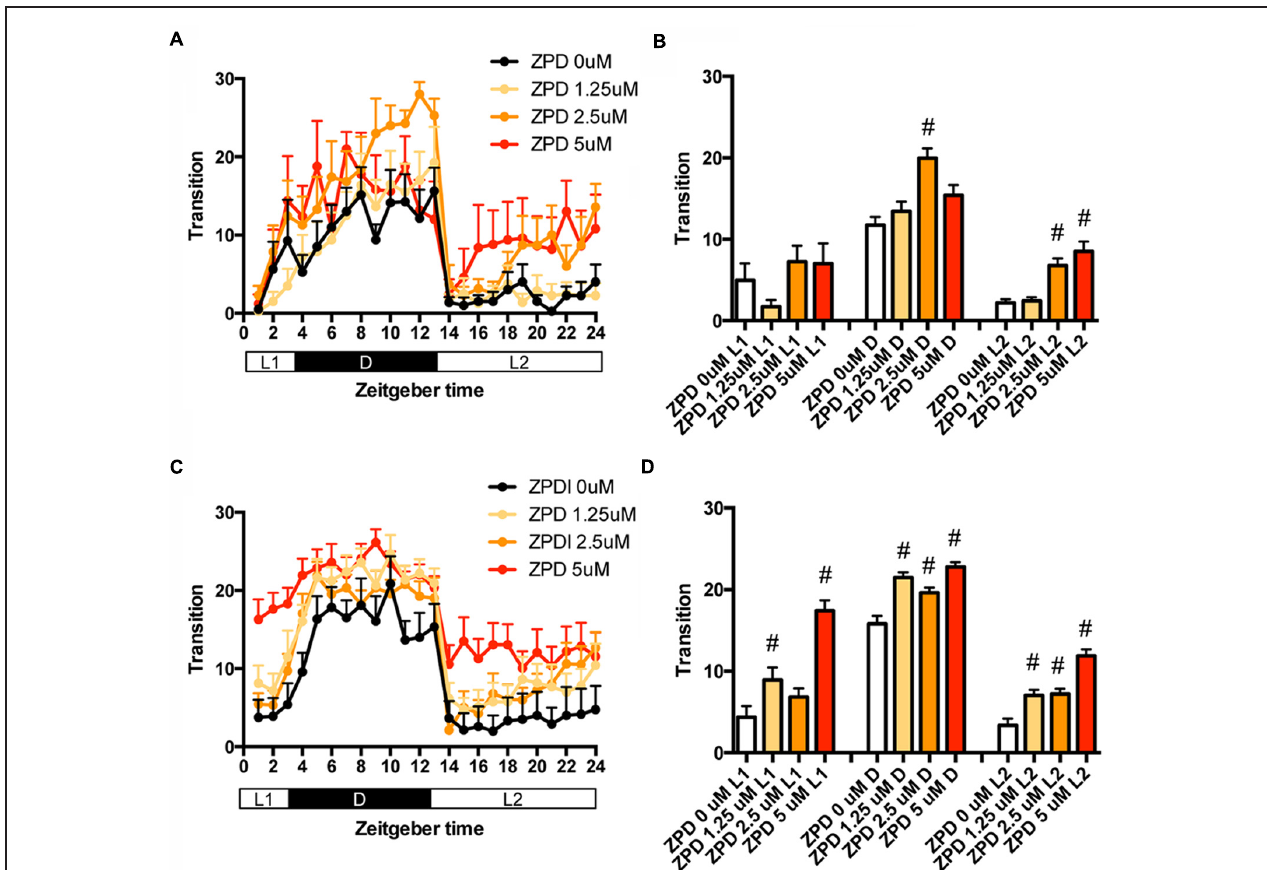
FIGURE 1 | Effects of zolpidem on the transition between rest and active states of zebrafish from 7 to 8 dpf and 9 to 10 dpf. The number of transition states of zebrafish treated with zolpidem from 7 to 8 dpf (A) and from 9 to 10 dpf (C) are shown for each hour. The number of transitions of zebrafish treated with zolpidem from 7 to 8 dpf (B) and from 9 to 10 dpf (D) are shown during L1 (ZT 0-3), D (ZT 3-13), and L2 (ZT 13-24). The data are represented as means with the standard error of mean. # p < 0.05 vs. control.